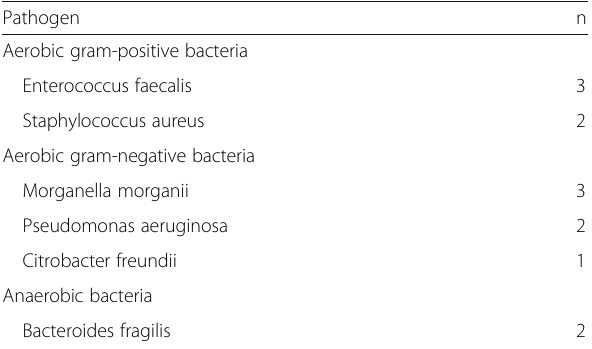
Table 3 Bacterial isolates identified from snakebite wounds of patients with Deinagkistrodon acutus envenomation who underwent surgery Pathogen n Aerobic gram-positive